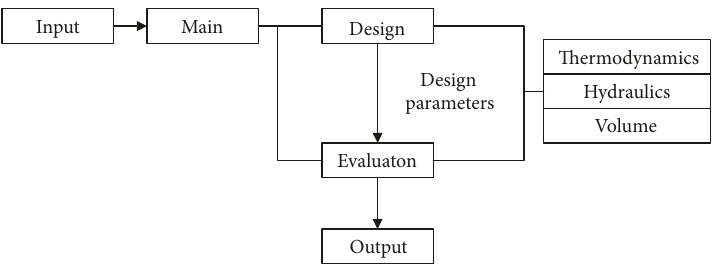
Figure 5: PRHR-HX evaluation procedure